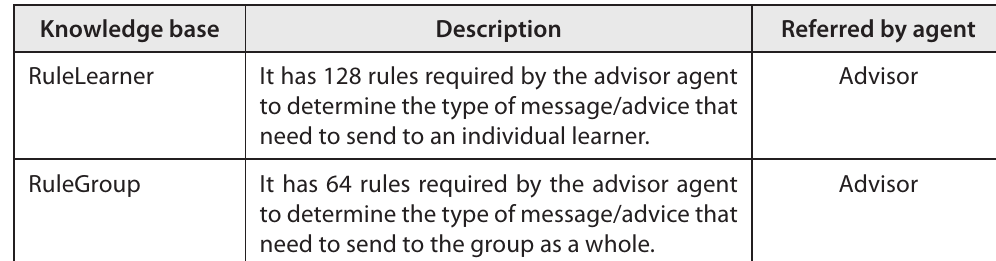
Table 3 Knowledge bases in the smart forum